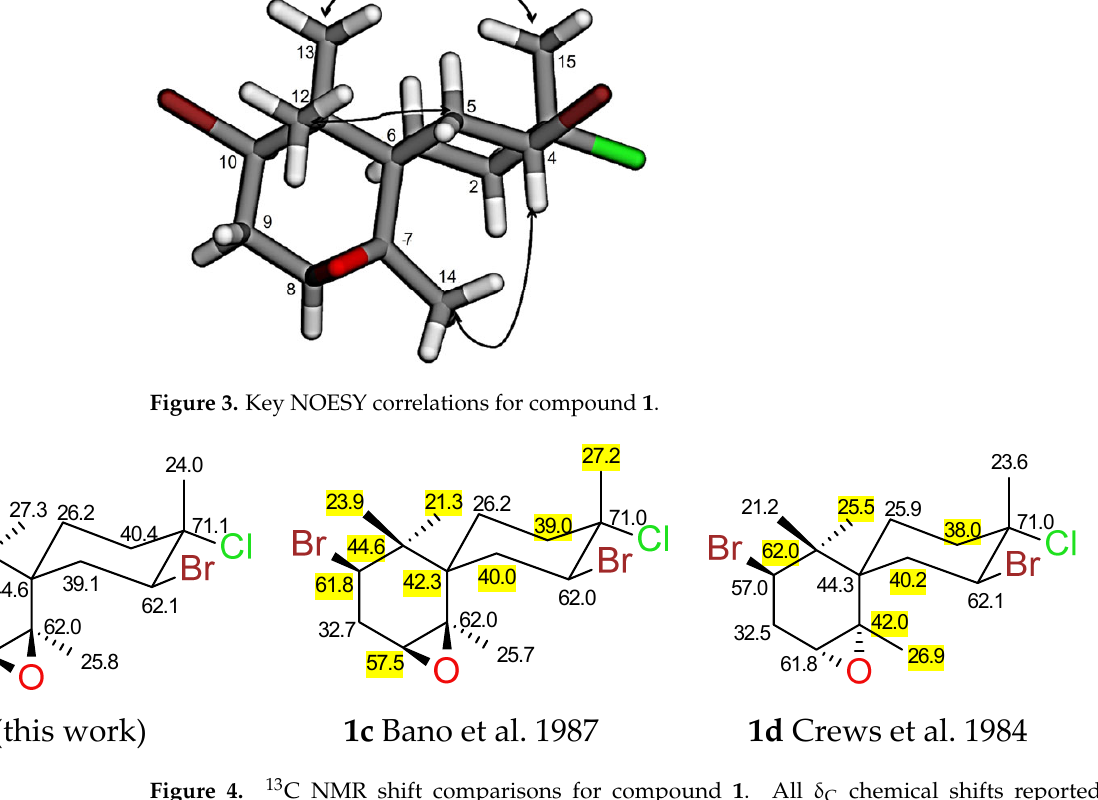
Figure 4. 13 C NMR shift comparisons for compound 1 . All δ C chemical shifts reported in CDCl 3 [22,23]. Chemical shifts in dispute are highlighted in yellow.